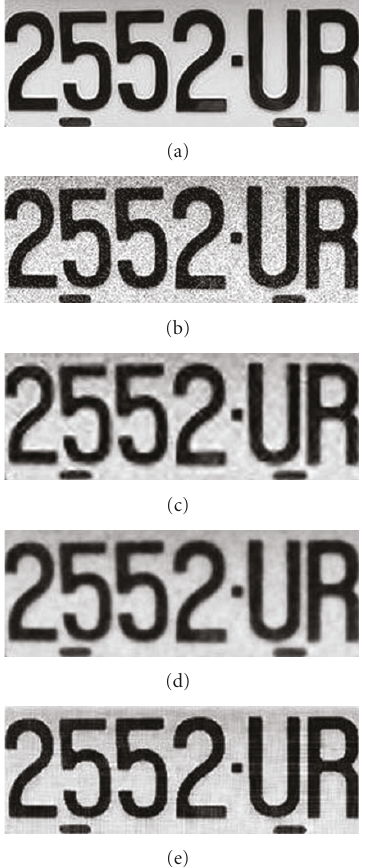
Figure 9: (a) “Number and Character”, (b) noisy image with Gaussian noise with σ = 0 . 01, (c) wavelet, PSNR = 21 . 946, (d) ADF, PSNR = 22 . 285, and (e) the proposed procedure, PSNR = 22 . 495.